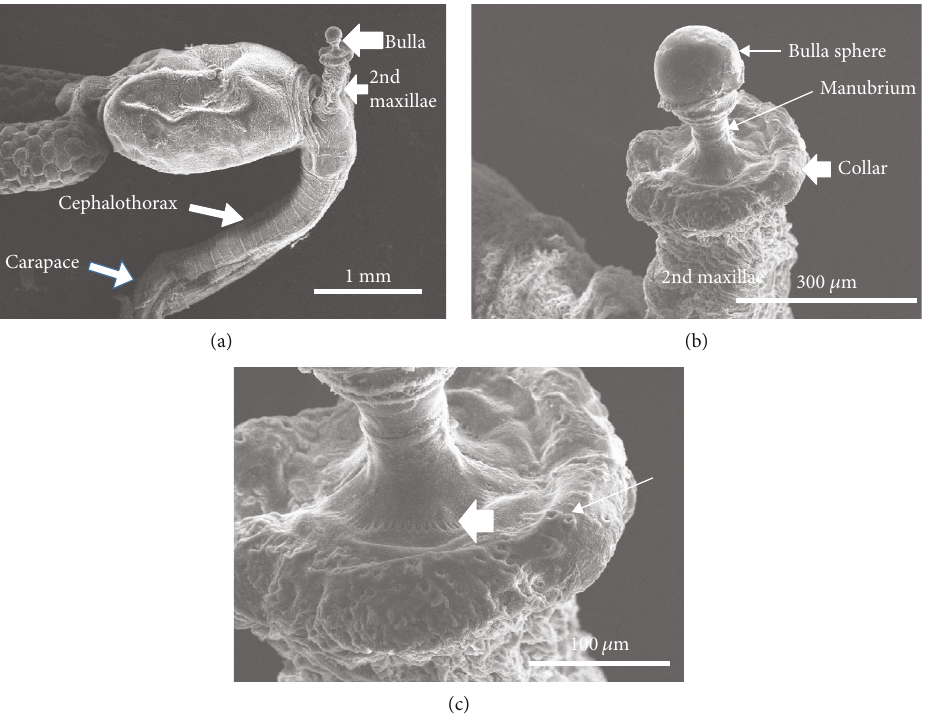
Figure 3: SEM bulla complex. (a) Overall view of trunk and cephalothorax. White large arrowhead indicates position of bulla complex with sphere, manubrium, and collar. Modi fi ed second maxilla supports the bulla complex. Note elongated cephalothorax and associated carapace. (b) Note detail of bulla complex showing the bulla sphere, manubrium, and collar supported by the second maxilla. (c) High-resolution detail of the manubrium and collar showing detail of manubrium ornamentation at base (large arrowhead) and pores on the surface of the collar (thin arrow).